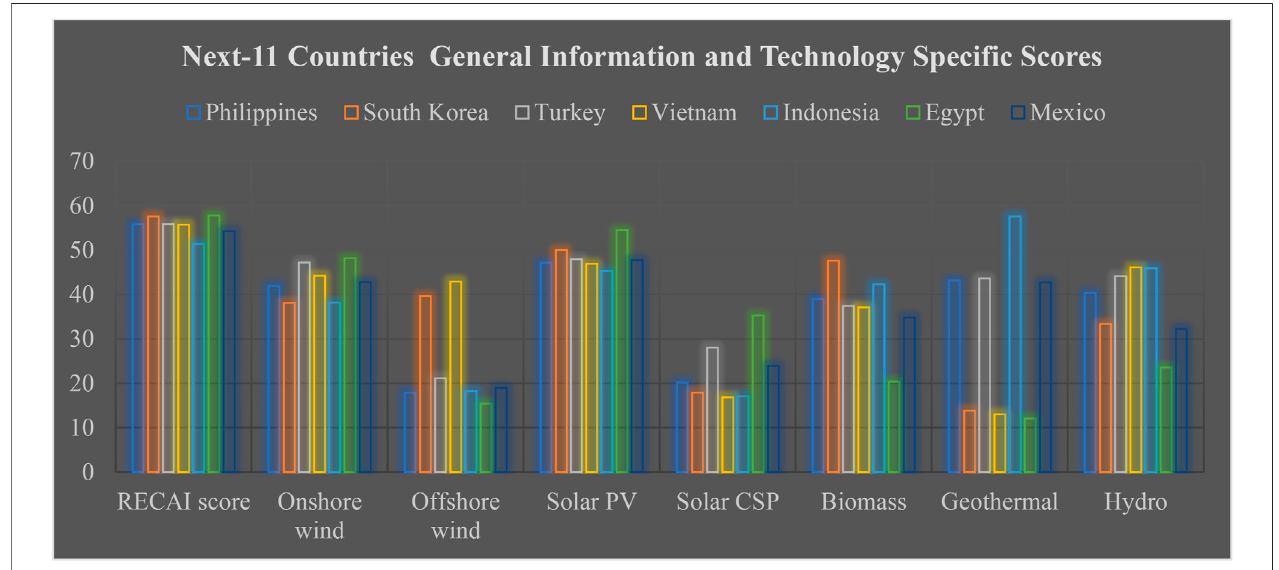
FIGURE 5 | Comparison of technology-speci fi c score of N-11